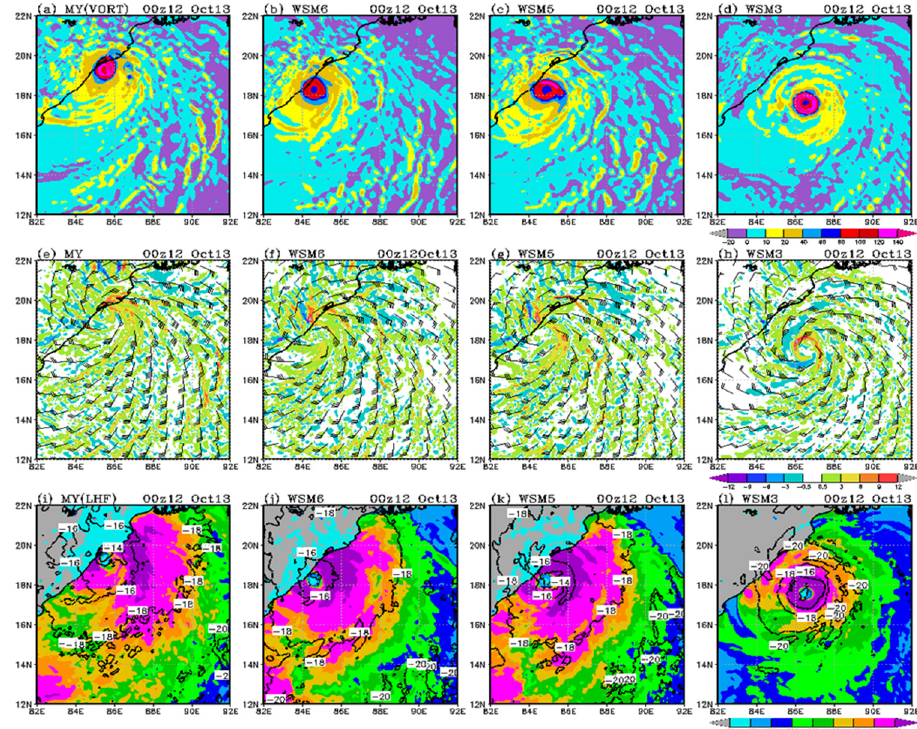
Figure 7. Average (1000–700 hPa level) vorticity field (× 10 5 s − 1 ) derived from WRF (D02) experi- ments using ( a ) MY, ( b ) WSM6, ( c ) WSM5, and ( d ) WSM3 schemes, valid at 00 UTC, 12 October 2013; similarly, vertical velocity (×10; ms − 1 ) and 10 m wind fields (knots) obtained with ( e ) MY, ( f ) WSM6, ( g ) WSM5 and ( h ) WSM3 schemes are shown; along with latent heat flux (W m − 2 , shaded) and temperature (°C; contours) at 300 hPa level derived from ( i ) MY, ( j ) WSM6, ( k ) WSM5, and ( l ) WSM3 experiments, respectively.